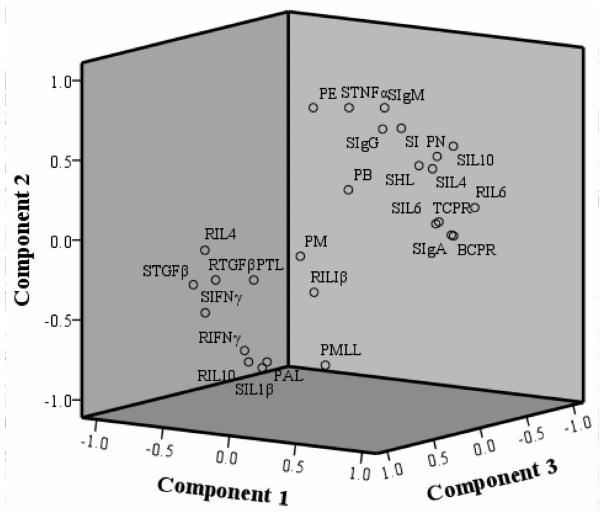
Figure 8. The component plot of the principal component analysis in